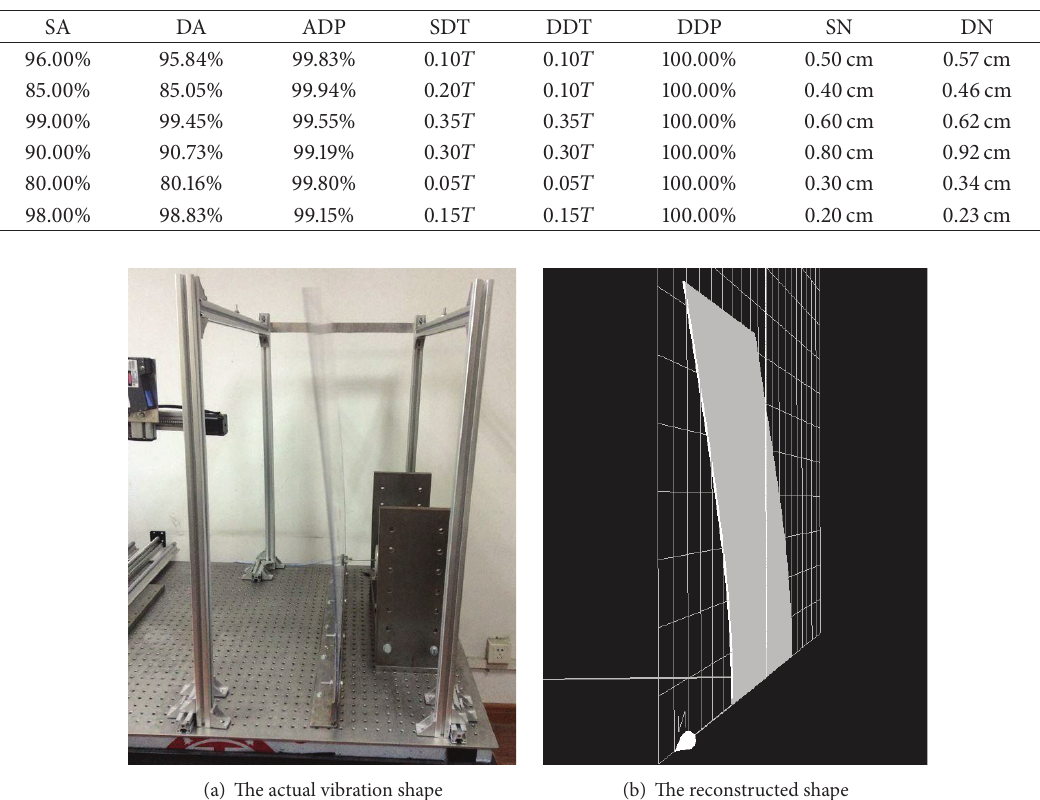
Table 1: Result of simulation analysis.